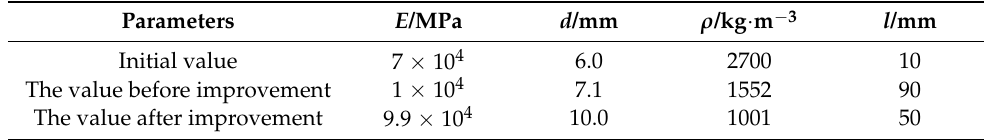
Table 2. The optimized results of the moving